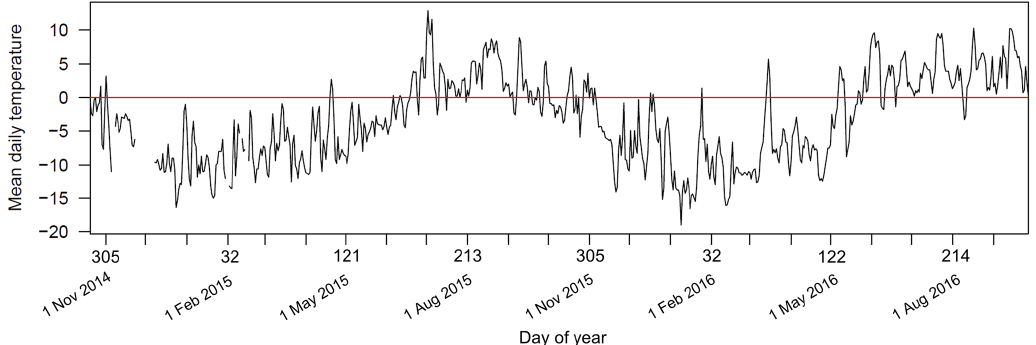
Figure A1. Temperature record from Juvvasshøe meteorological station (ID 15270, 1894ma.s.l.) from October 2014 to October 2016 (downloaded from eKlima.no, 2016).